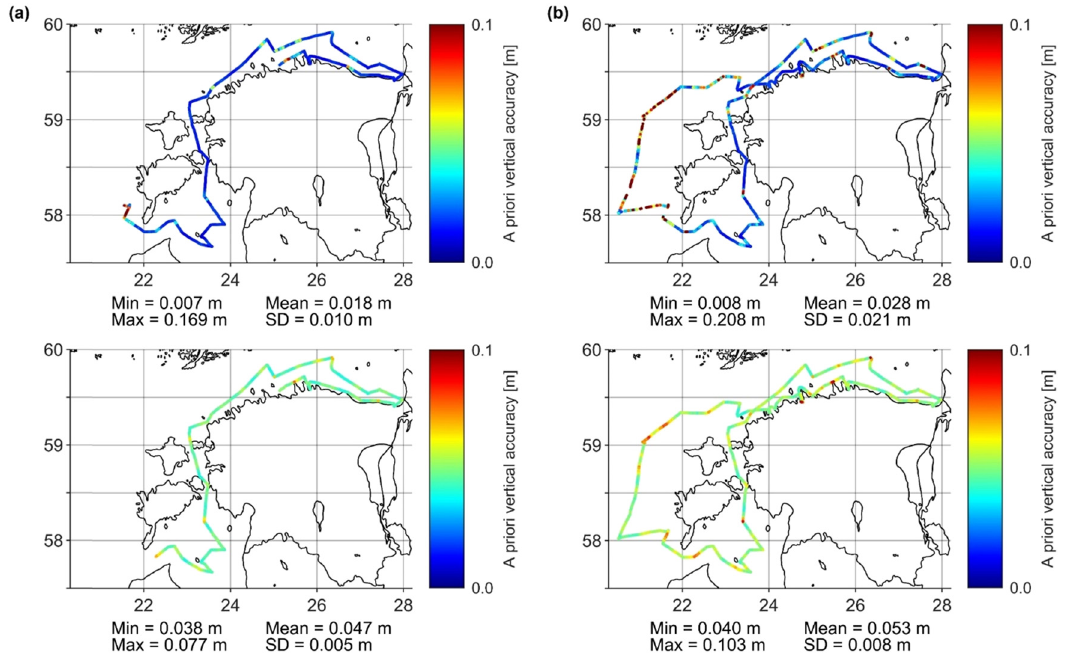
Figure 5: A priori vertical accuracies of the bow - mounted antenna A1 ( a ) and the top - mounted A3 ( b ) during the C2 campaign, estimated by TBC ( top ) and CSRS - PPP ( bottom )